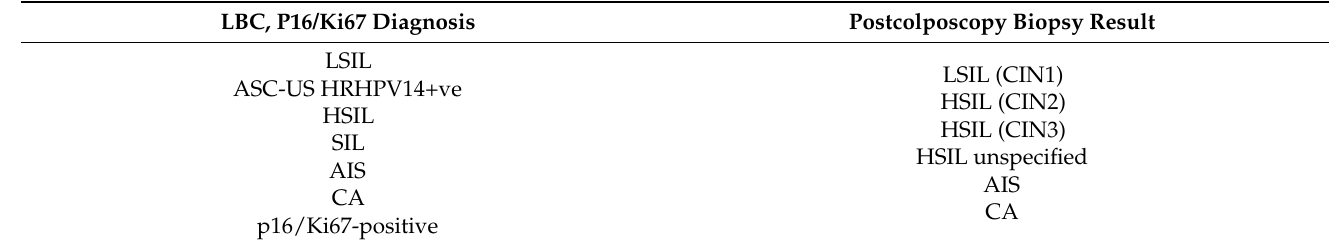
Table 1. Selected QA/QC tools used in CQI protocol-groups of positive cytologic-immunocytochemical-histologic correla- tions with modification for the study *.